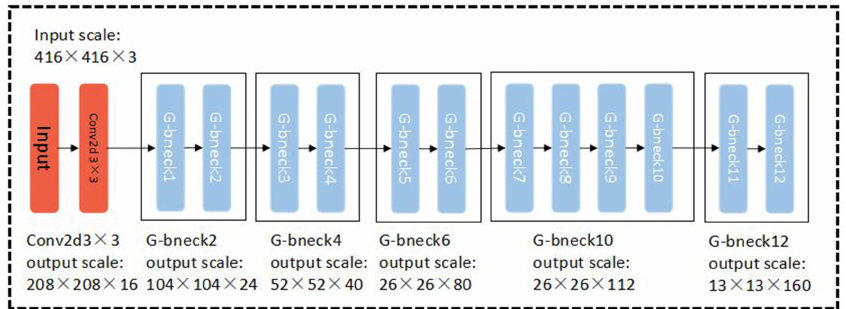
Figure 7. Improved GhostNet network structure . The improved GhostNet trims the four G-bneck modules, the AvgPool layer, and the FC layer from the original